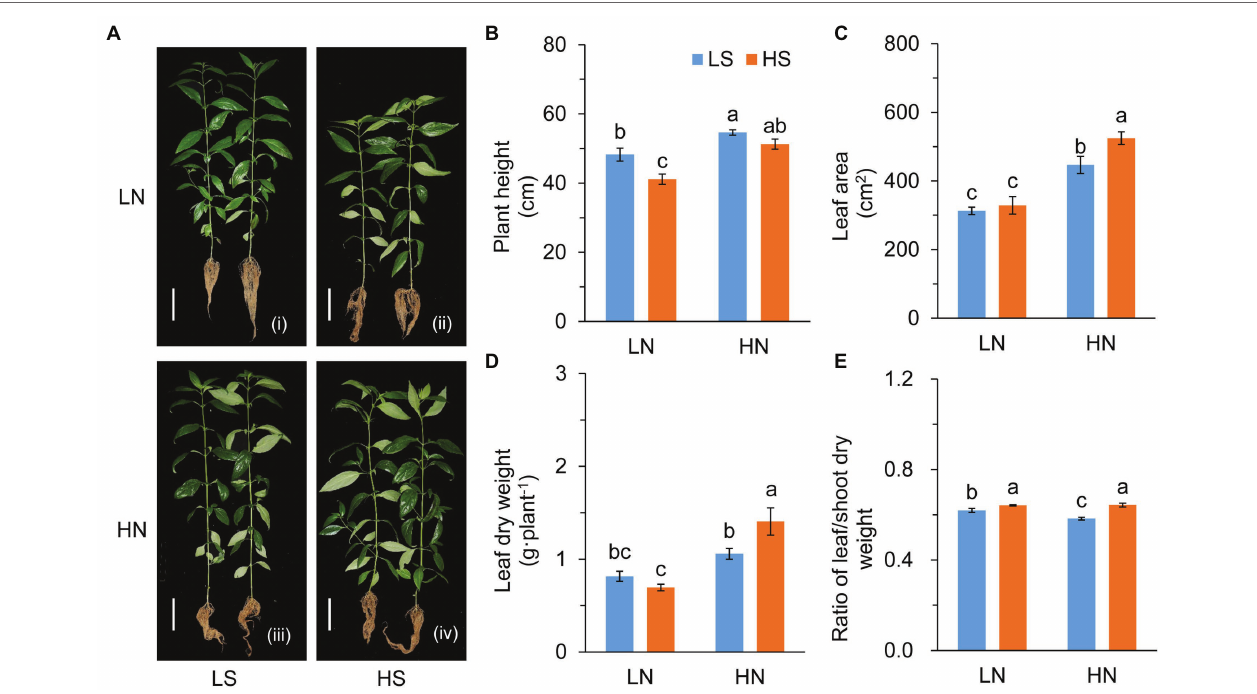
FIGURE 1 | Growth evaluation of A. paniculata plants grown under different nitrogen and sulfur conditions. (A) Plants treated with different N and S levels were pictured after harvesting. (B) Plant height. (C) Leaf area measured by photographing. (D) Leaf dry weight. (E) The ratio of leaf/shoot dry weight. Data were presented as mean ± SE ( n = 4). Different letters on the bars indicate significant difference among treatments at p < 0.05 using the method of LSD . Scar bars = 10 cm. LN, low nitrogen; HN, high nitrogen; LS, low sulfur; HS, high